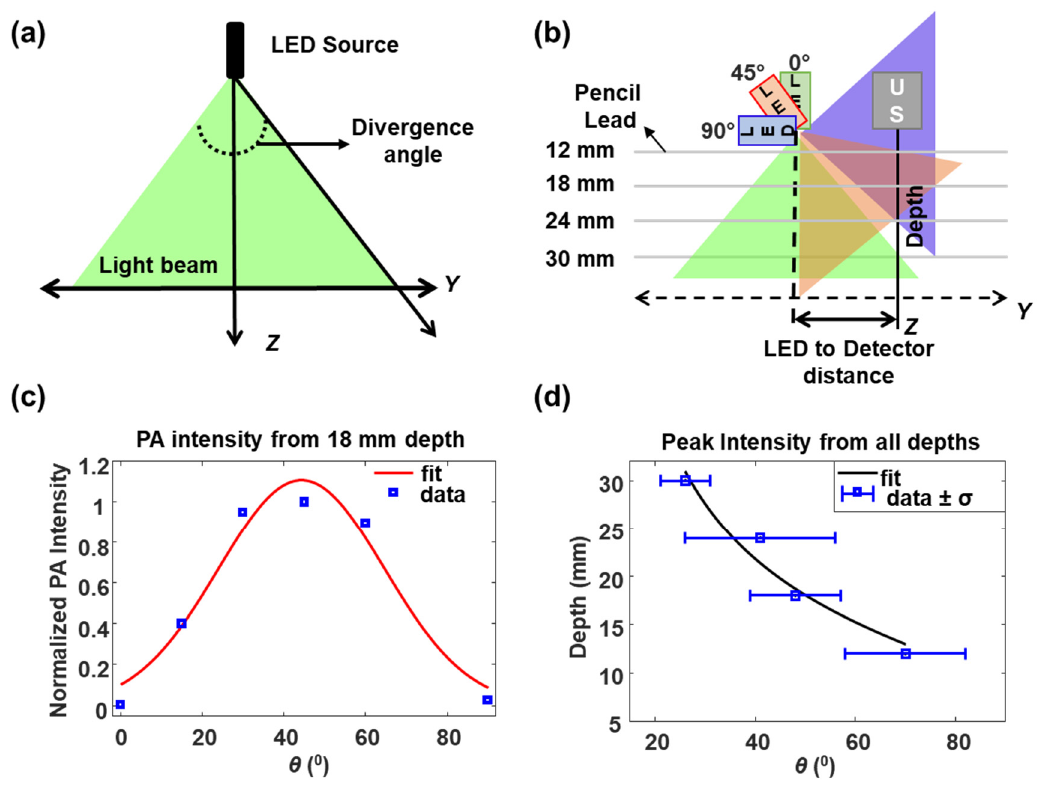
Figure 4. ( a ) Illustration of the source wavefront profile, while assuming the LED array as a line source with Gaussian profile having divergence described by Equation (4); ( b ) Source profile after pivoting LED arrays at three different angles in the imaging plane–green at 0°, red at 45°, and blue at 90°; ( c ) Normalized PA intensity obtained from 18 mm target vs. LED illumination angle, θ , is indicated in blue squares. The red solid curve shows the Gaussian fit using Equation (5), with an R-squared value of 0.95; ( d ) Blue squares with error bar show the peak PA intensity with standard deviation for each depth plotted as a function of θ for pencil lead phantom data in water. The black solid curve displays the best fit using a cotangent function (R 2 = 0.95).